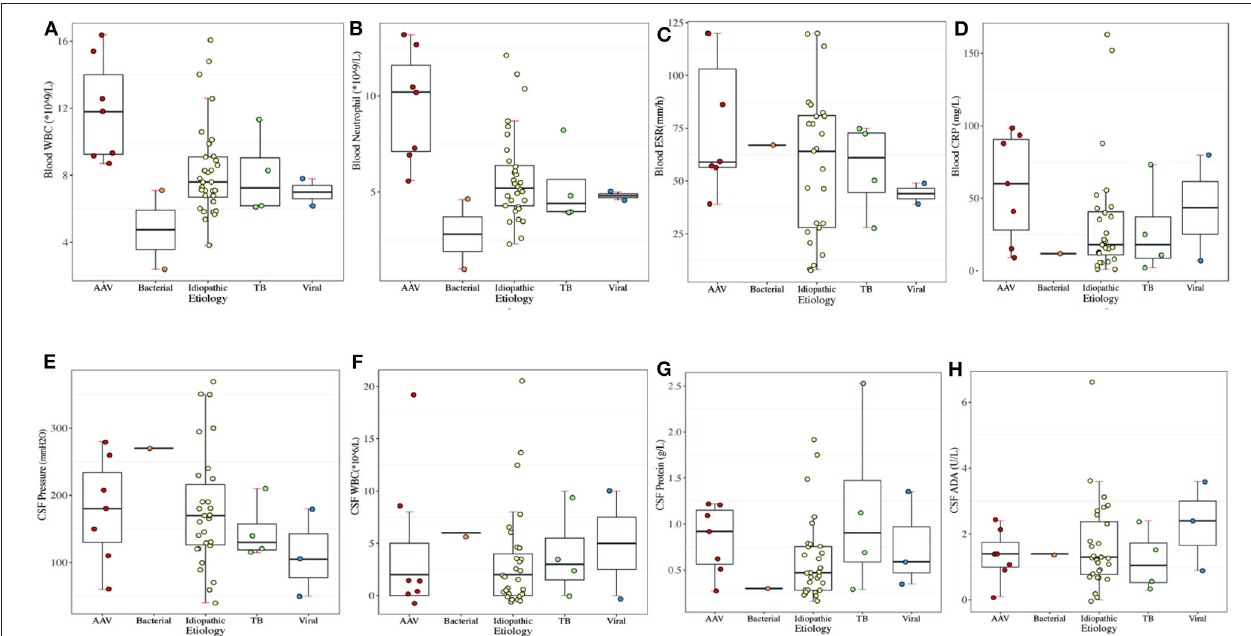
FIGURE 3 | Laboratory results of periphery blood in different etiologies of HP. (A) Blood WBC (normal range: 3.5–9.5 × 10 9 /L). (B) Blood neutrophil count (normal range: 1.8–6.3 × 10 9 /L). (C) Blood ESR (normal range: 0–21 mm/h). (D) Blood CRP (normal range: 0–8 mg/L). (E) CSF WBC (normal range: 0–8 × 10 6 /L). (F) CSF